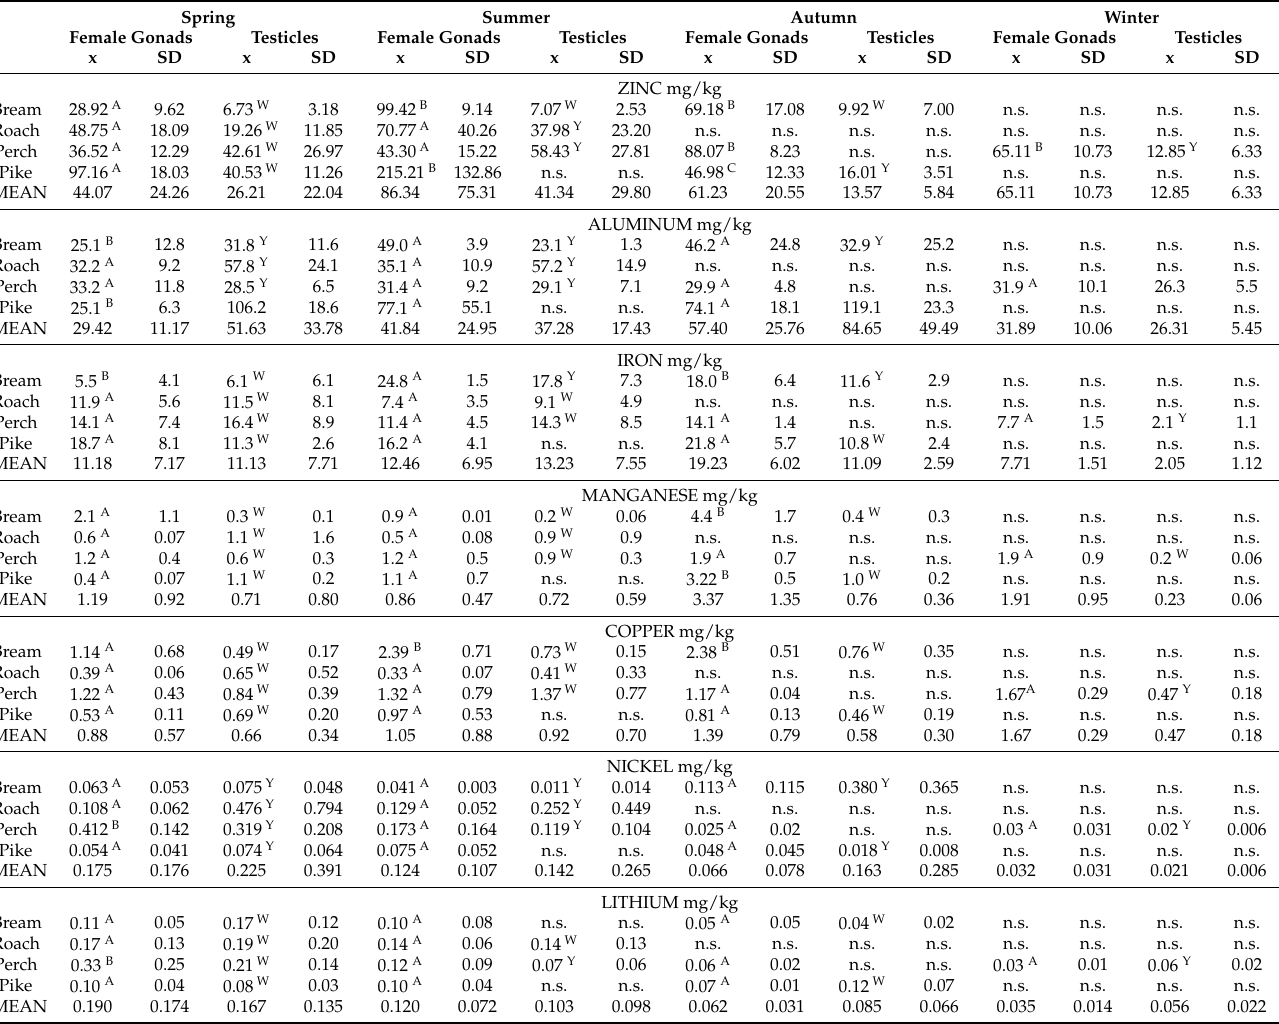
Table 4. Content of trace elements in female gonads and testicles in different seasons of the year.